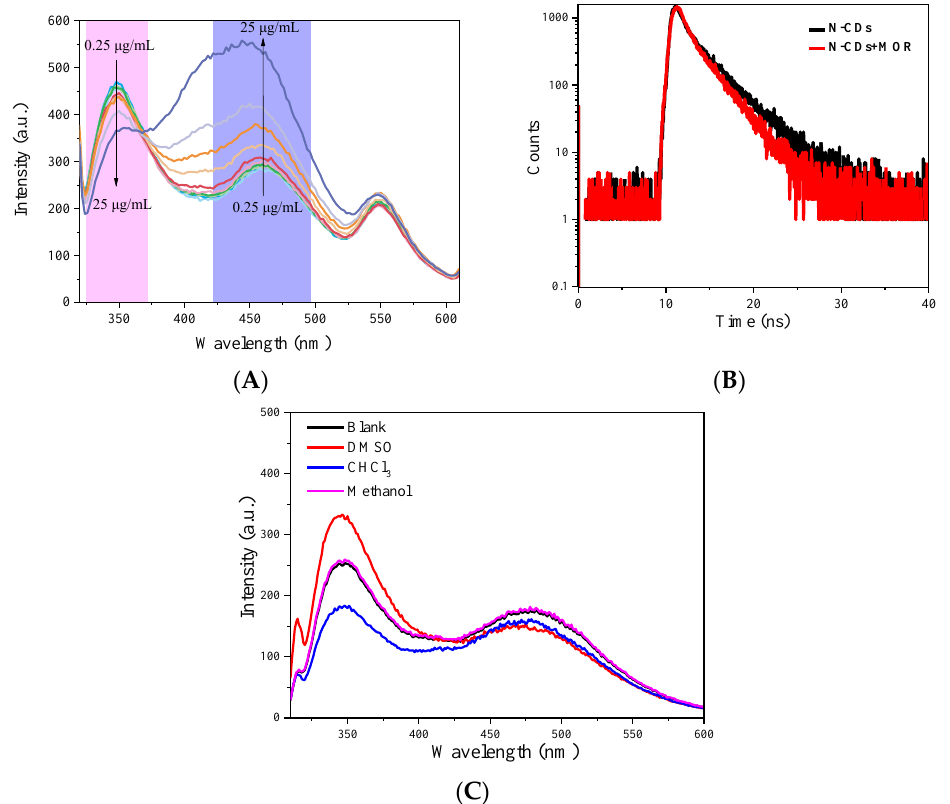
Figure 8. ( A ) Fluorescence spectra of N-CD solution with different concentrations of morphine. ( B ) The fluorescence lifetime curve of N-CDs and N-CDs + morphine. ( C ) The fluorescence spectra of N-CDs in different apolar solvents.